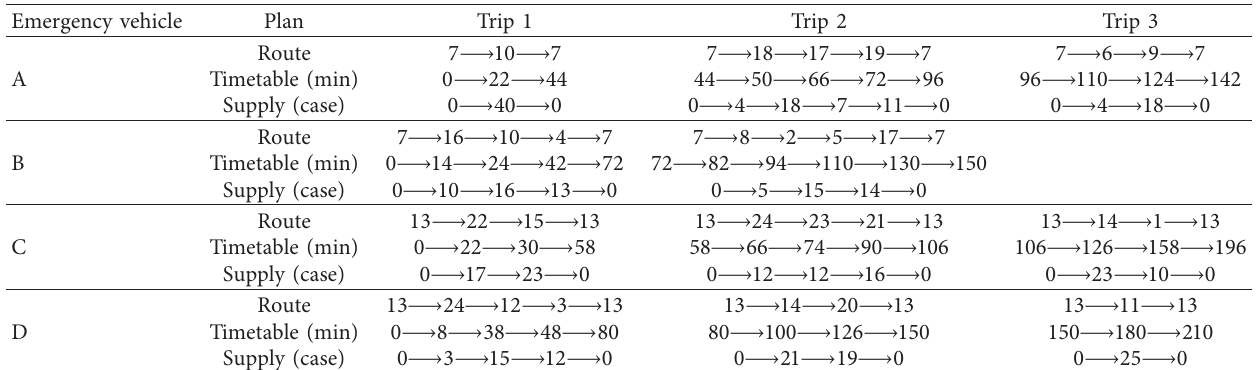
Table 5: Control